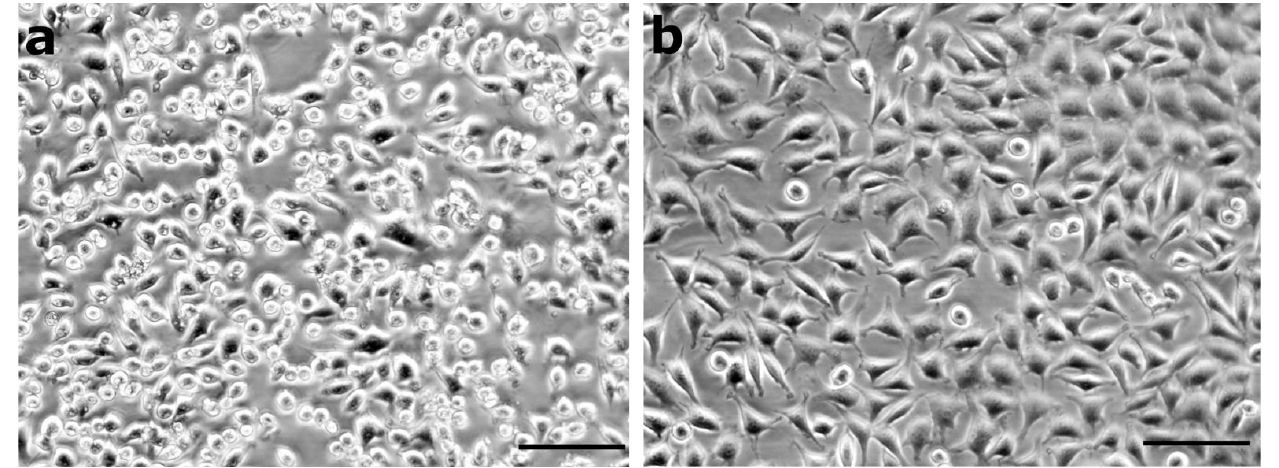
Figure 1. Typical appearance and confluency of cells prior to cell passage. ( a ) NCTC clone 1469; cell culture medium was removed prior to this photo (see Section 3.2.1 step 22). ( b ) NCTC clone 929. Scale bar represents 100 µm.